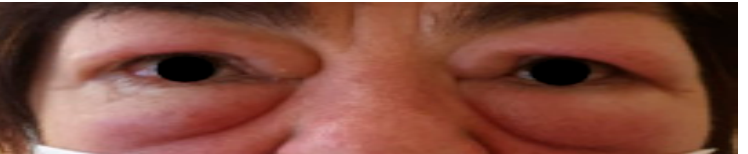
Table 2. Clinical Activity Score—CAS (amended by EUGOGO after Mourits et al.). One point is given for the presence of each of the parameters assessed, the sum defines clinical activity